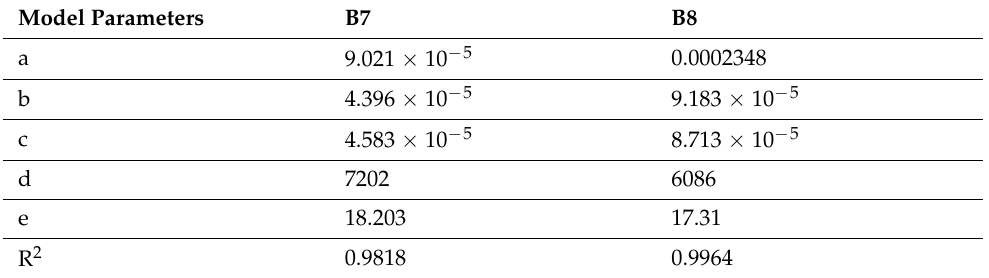
Table 7. Model parameter with fixed values for f_l0 and f_s0, for batteries with multiple stress. Model